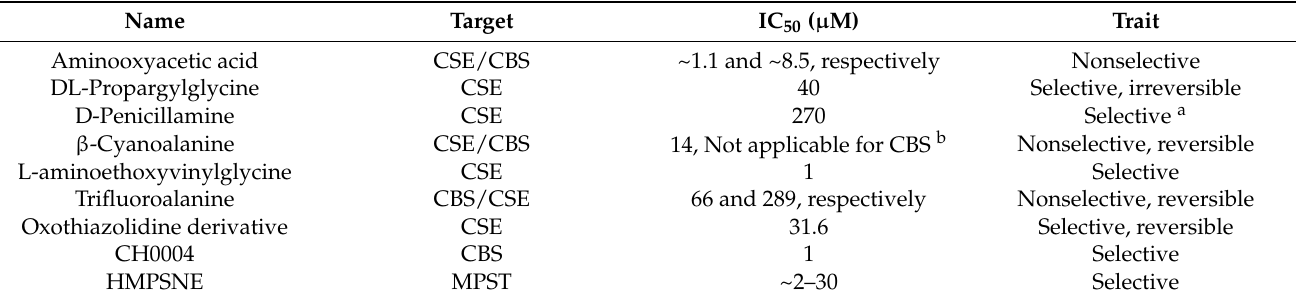
Table 1. A brief summary of common H 2 S-producing enzyme inhibitors.